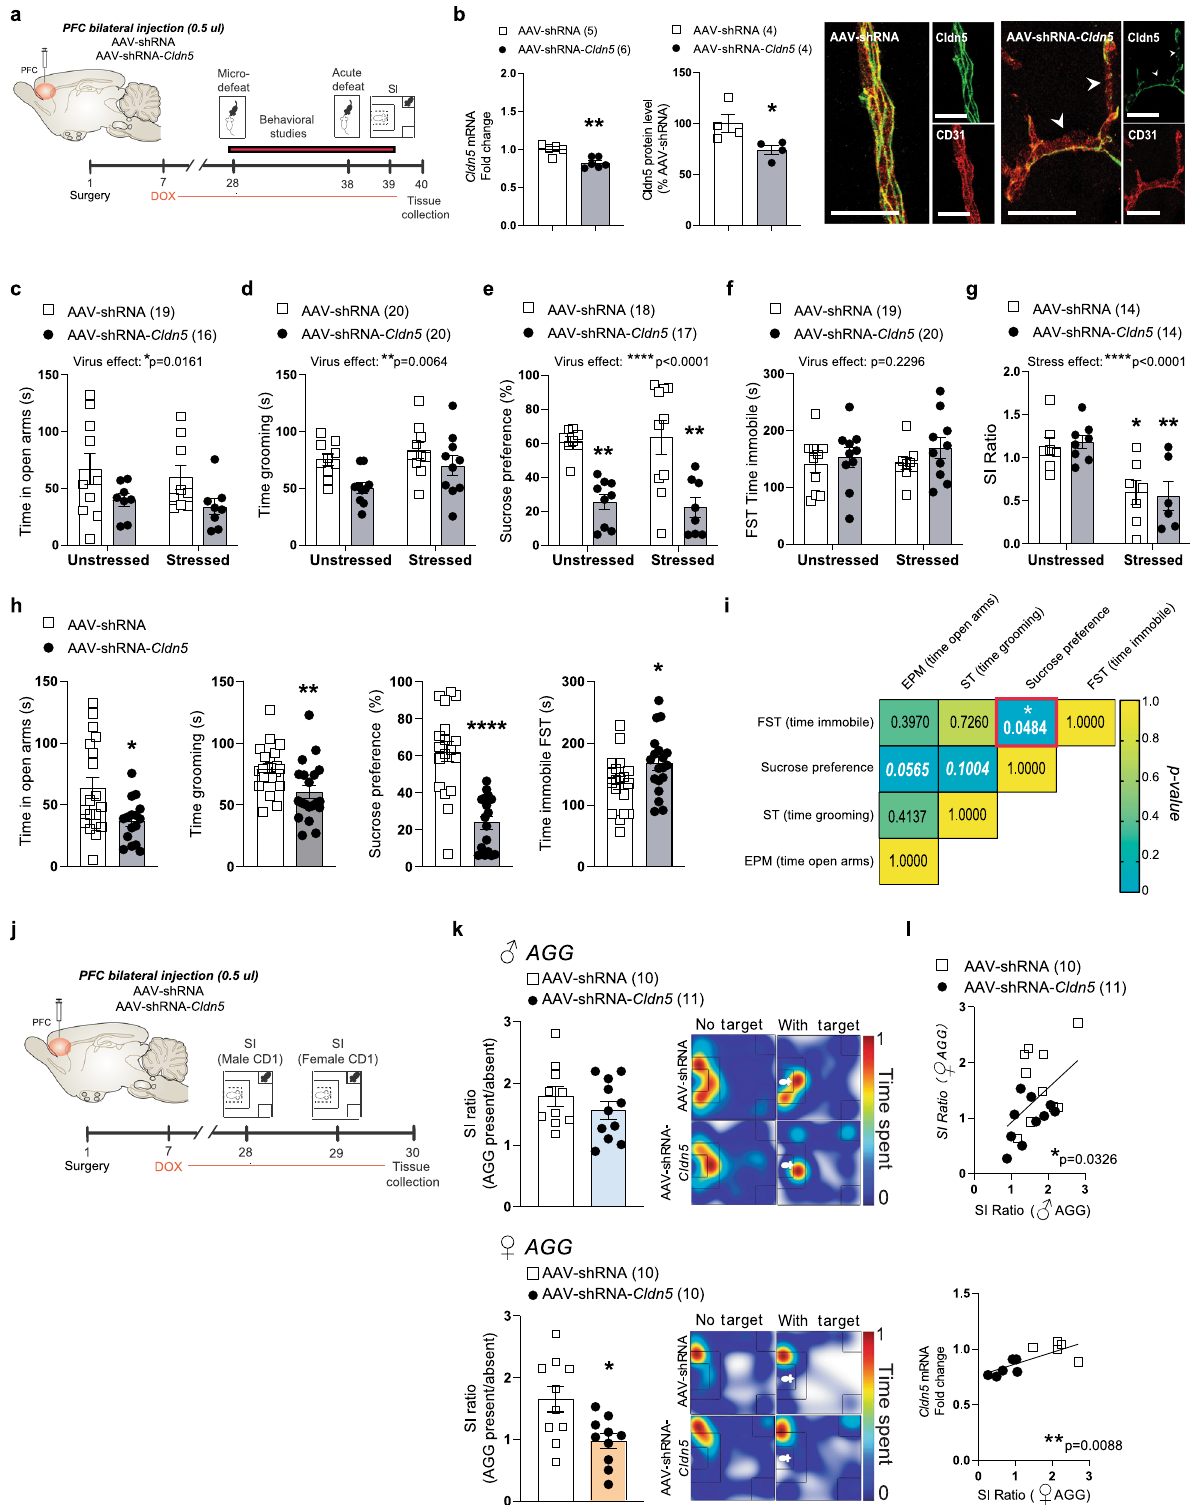
to vascular health. Female mice underwent the 10-d CSDS or 6-d SCVS paradigm and blood was collected 3 days before the fi rst exposure to a stressor and 24 h after the last stress (Fig. 6c, d and Supplementary Fig. 9a – c). Social and variable stress were asso- ciated with signi fi cant changes in soluble adhesion molecule sE- selectin (CSDS: p = 0.0267), soluble plasminogen activator inhibitor-1 (sPAI-1, CSDS: p = 0.0004, SCVS: p = 0.0010), pro-